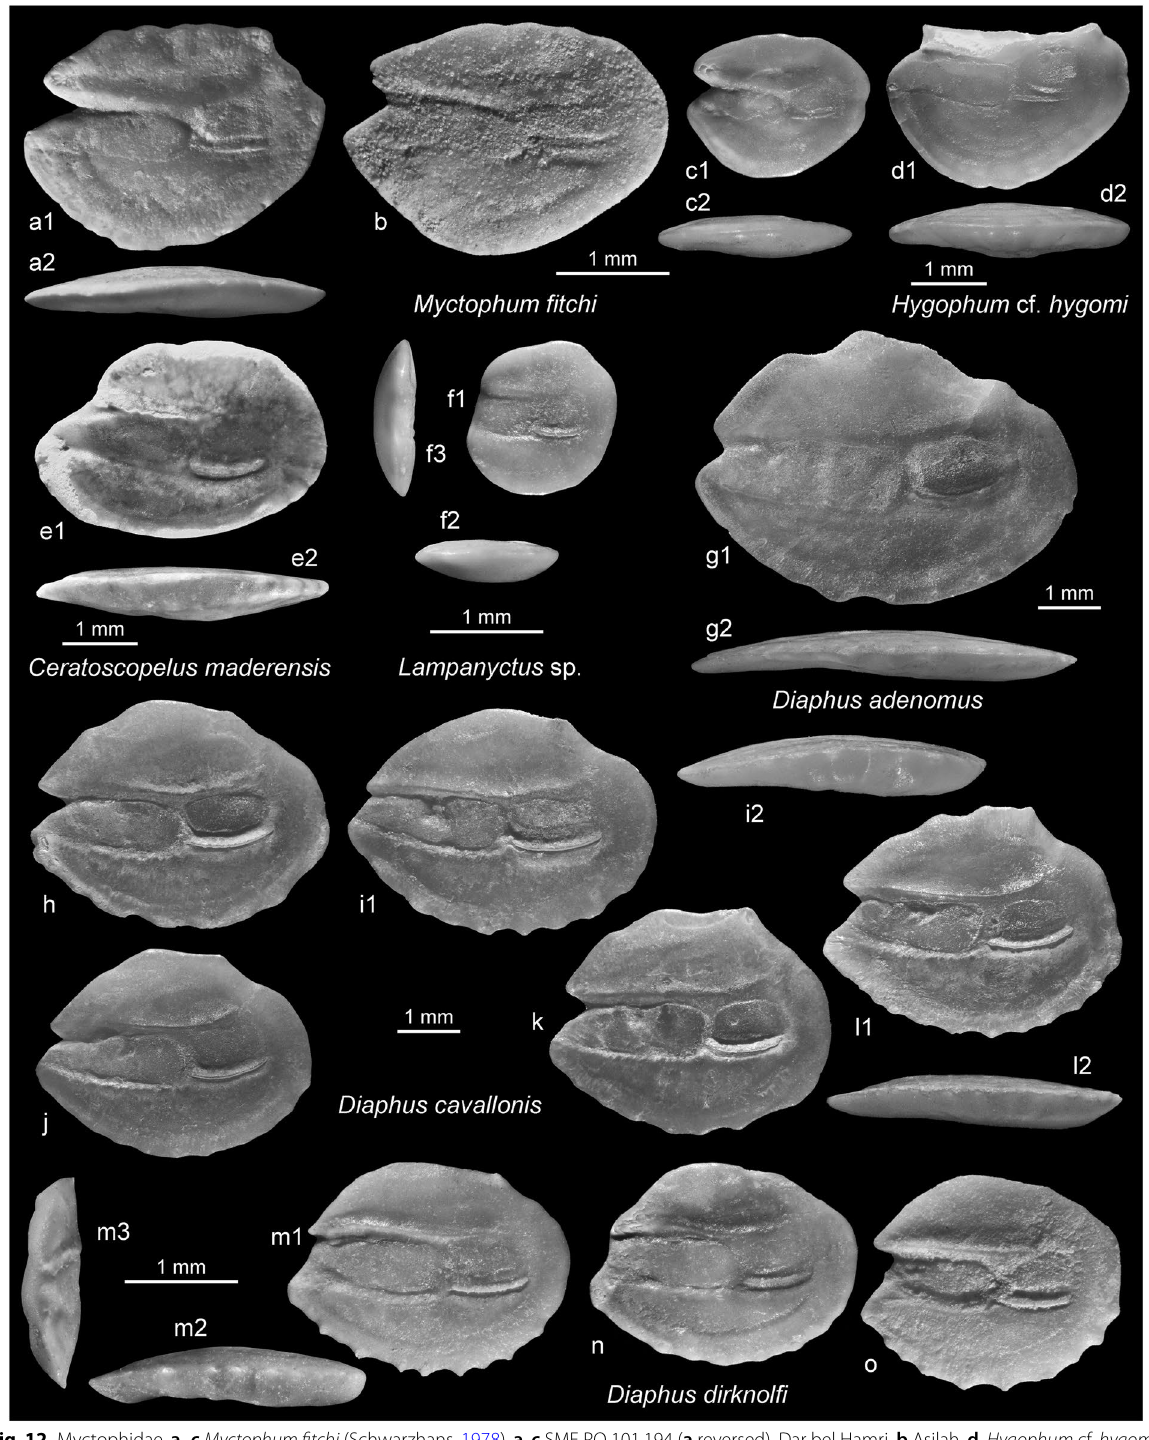
Fig. 12 Myctophidae. a – c Myctophum fitchi (Schwarzhans, 1978), a , c SMF PO 101.194 ( a reversed), Dar bel Hamri, b Asilah. d , Hygophum cf. hygomi (Lütken, 1892), SMF PO 101.193, Dar bel Hamri. e Ceratoscopelus maderensis (Lowe, 1839), SMF PO 101.195, Dar bel Hamri. f , Lampanyctus sp. SMF PO 101.196, Dar bel Hamri. g , Diaphus adenomus Gilbert, 1905, SMF PO 101.274 (reversed), Dar bel Hamri. h – l Diaphus cavallonis Brzobohatý &